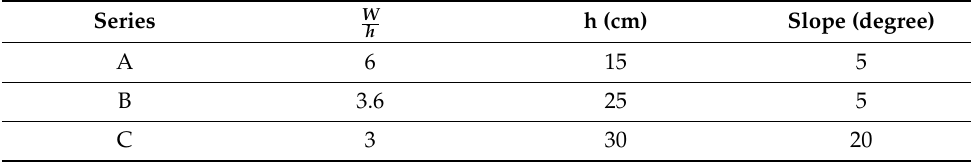
Table 2. Flow conditions in the laboratory